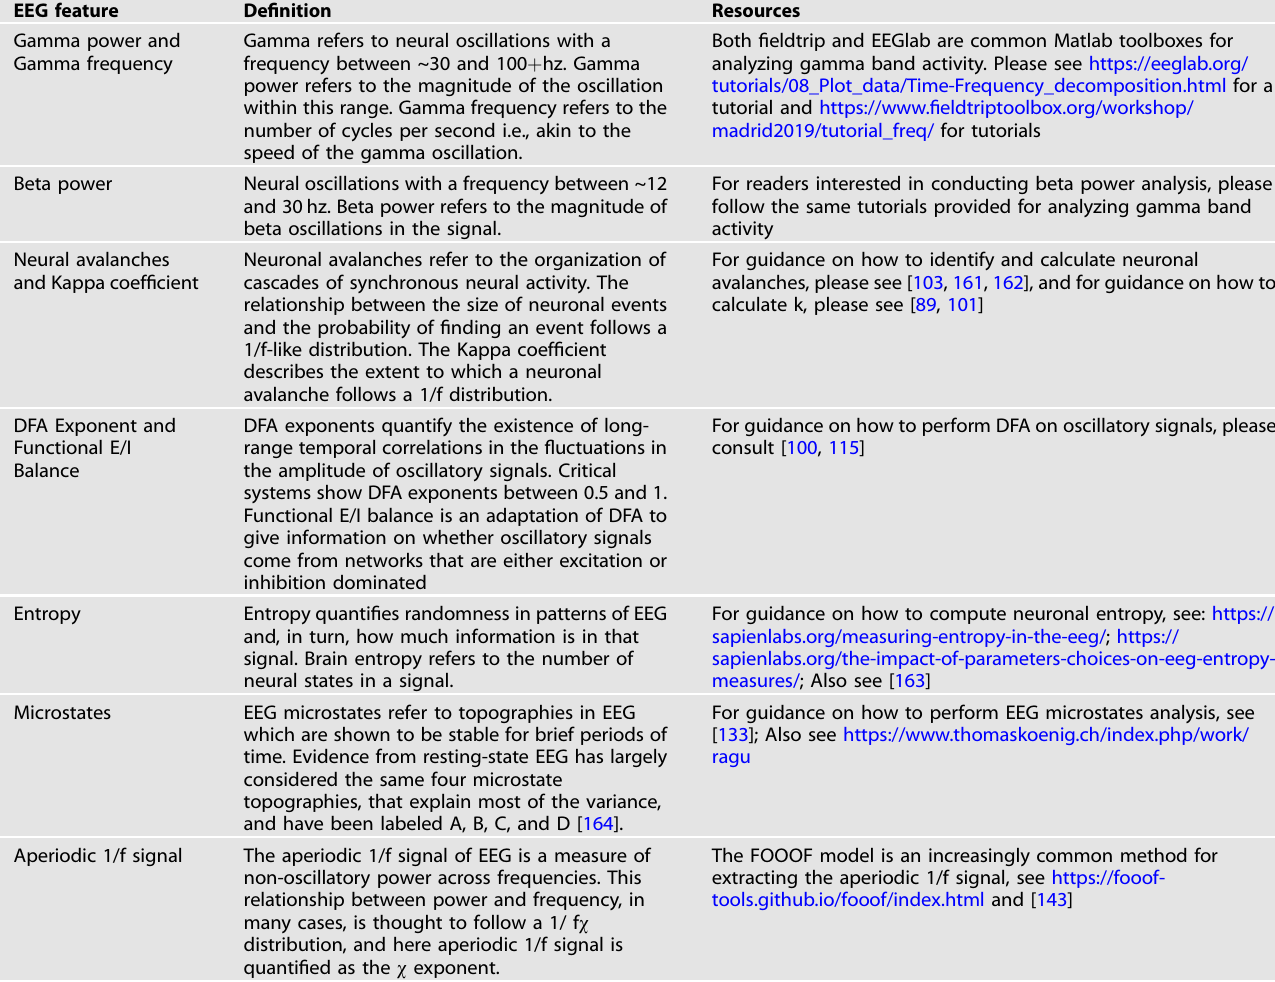
Table 1. De fi nition and resources for guidance on how to analyze each EEG marker. EEG feature De fi nition Resources Gamma power and Gamma